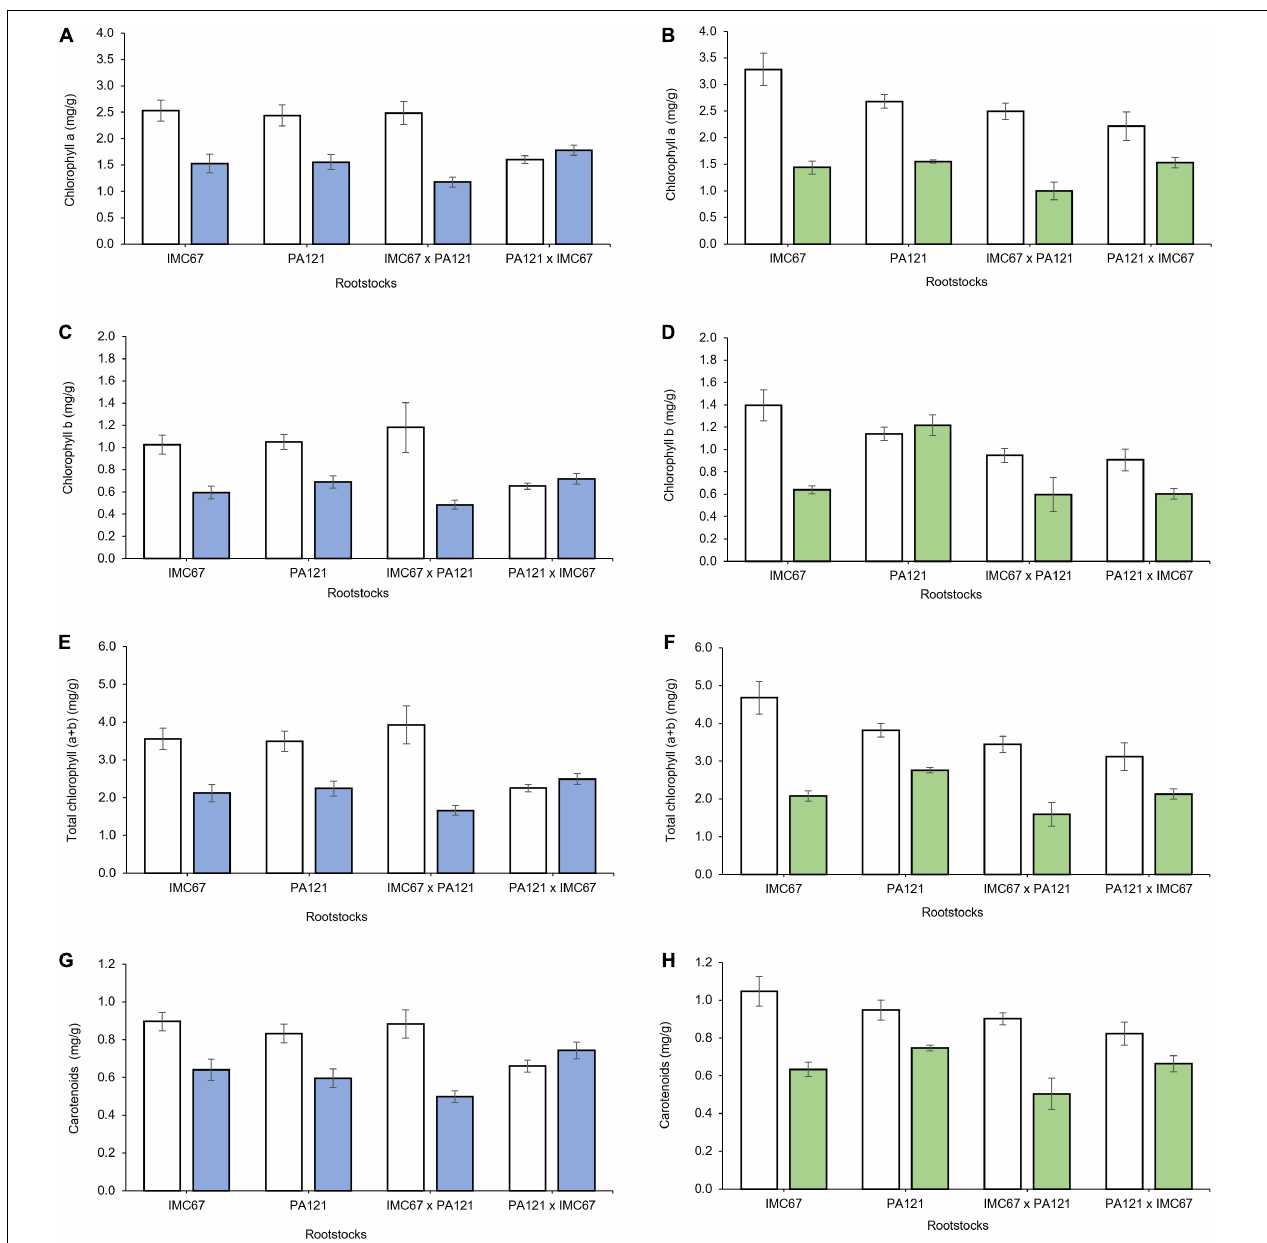
FIGURE 10 | Content of chloroplast pigments in ICS95 and CCN51 clonal scions 2 months after grafting on four different seedling rootstock families subjected to two different concentrations of Cd in soil under greenhouse conditions. Panels (A,B) show content of Chlorophyll a of ICS95 and CCN51 clonal scions. Panels (C,D) depict content of Chlorophyll b of ICS95 and CCN51 clonal scions. Panels (E,F) exhibit content of total Chlorophyll of ICS95 and CCN51. Panels (G,H) show content of carotenoids of ICS95 and CCN51 clonal scions. White bars represent rootstocks × scion combinations grown in soil without addition of cadmium (0.43 mg kg − 1 ). Blue bars show seedling rootstock families grafted with the ICS95 clonal scion grown in Cd spiked soil (7.49 mg kg − 1 ). Green bars depict seedling rootstock families grafted with the CCN51 clonal scion grown in Cd spiked soil (7.49 mg kg − 1 ). Data are mean values ± SE ( n = 8).